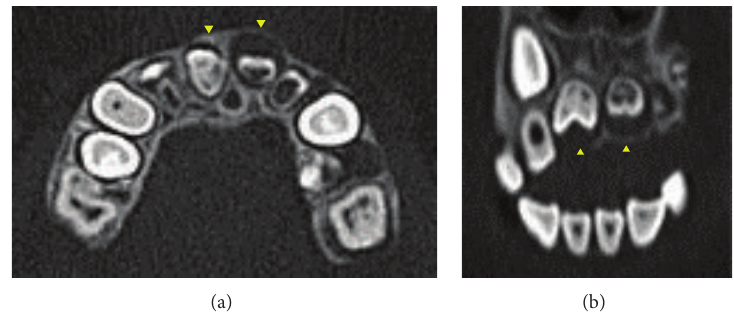
Figure 7: CT images of case 1. (a) Axial CT image shows labial expansion of dental follicles (arrowheads). (b) Multiplanar reconstruction image shows dental follicles clearly expanding toward alveolar ridge (arrowheads).